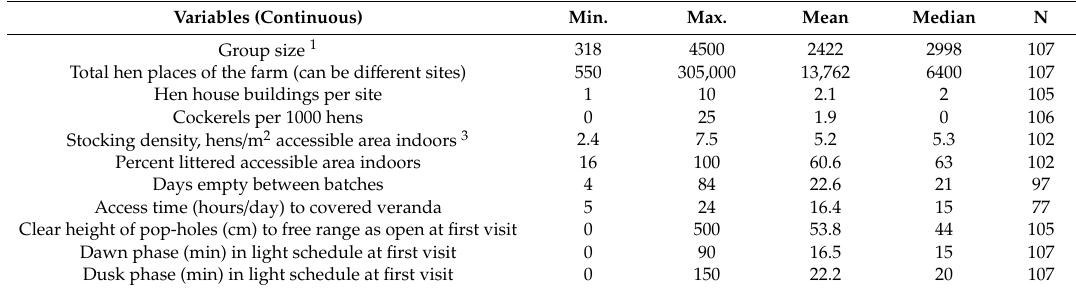
Table 4. Range (minimum, maximum), mean and median of continuous husbandry characteristics in a sample of 107 organic laying hen flocks assessed in eight European